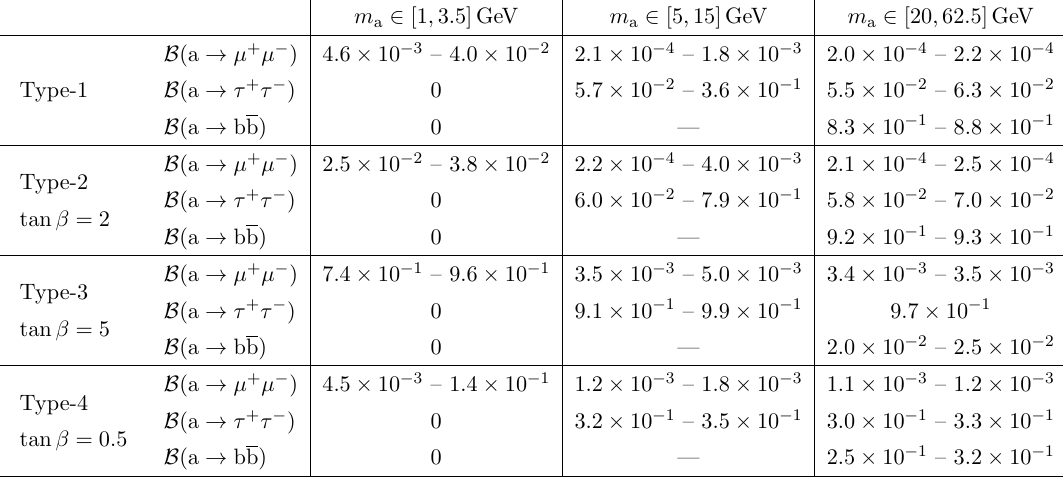
Table 7 . Branching fractions of the pseudoscalar boson a to muons, (cid:28) leptons, and b quarks, in the four 2HDM+S scenarios considered in (cid:12)gure 8, as a function of the light boson mass. The branching fraction B (a ! bb) is not indicated in the mass range m a 2 [5 ; 15] GeV because it is not used to interpret the